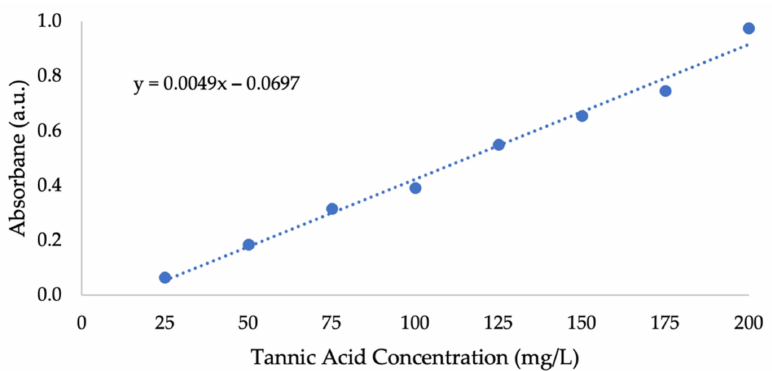
Figure A3. Tannic acid calibration curve.